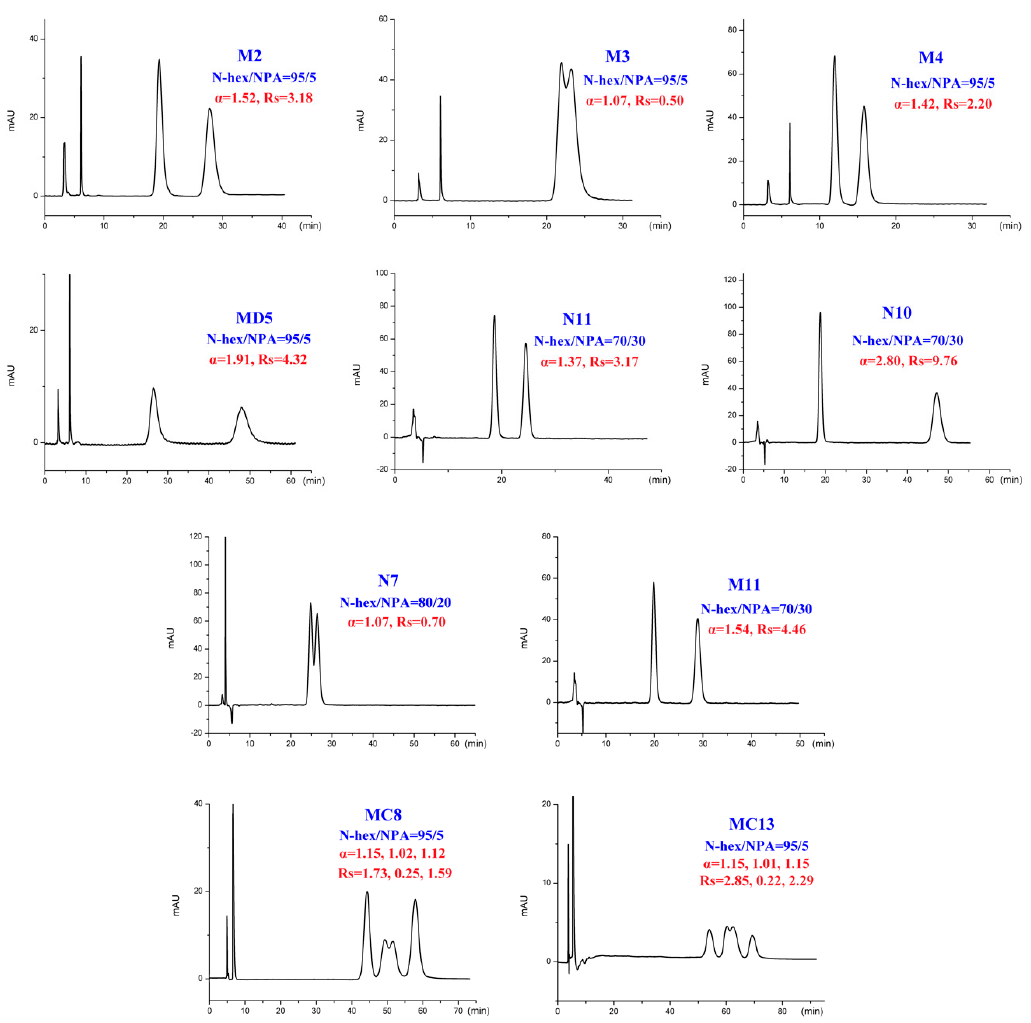
Figure4. Figure 4. Typical chromatograms with n-propanol (NPA) as organic modifier under normal-phase mode.